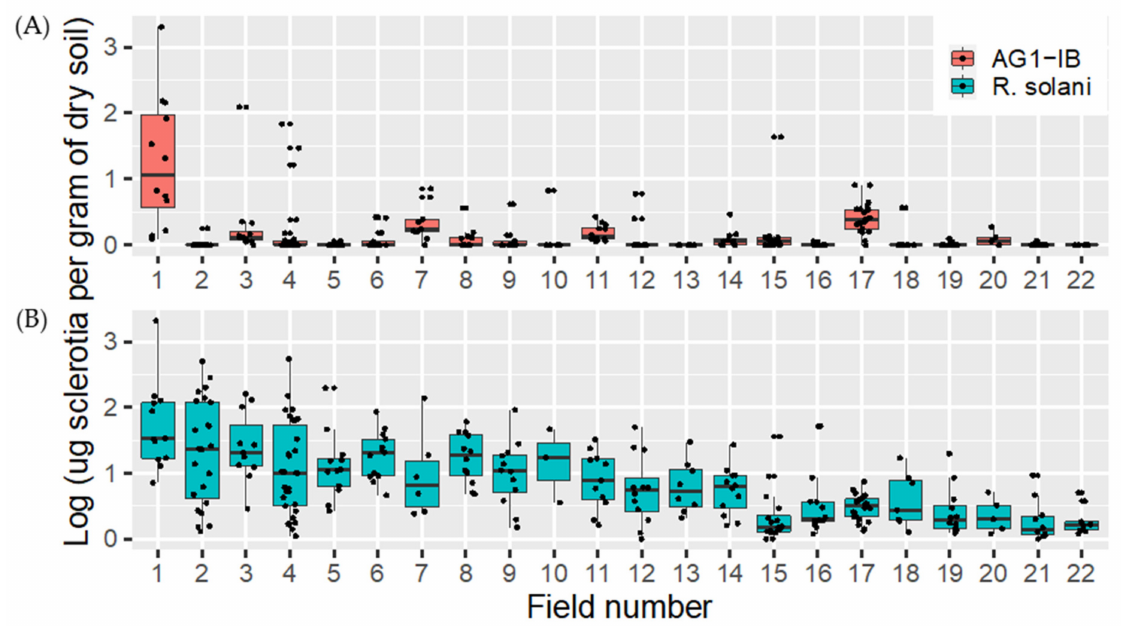
Figure 6. Box plot diagram showing the amount of ( A ) R. solani AG-1-IB log10 µ g sclerotia per gram of dry soil and ( B ) Rhizoctonia solani log µ g sclerotia per gram of dry soil detected by qPCR methods in commercial fields sampled in spring 2017 and 2018 prior to lettuce planting. The fields are placed in ascending order of their mean value for R. solani